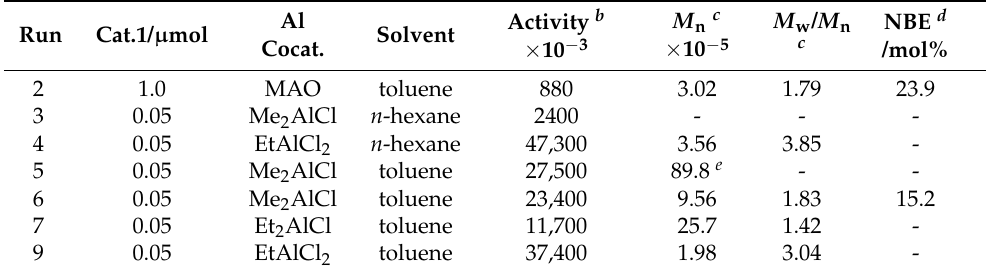
Table 1. Effect of Al cocatalyst, solvent and ETA (Cl 3 CCO 2 Et) in ethylene polymerization